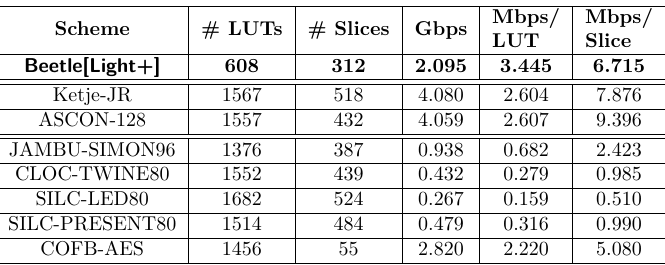
Table 6: Benchmarking Beetle[Light+] on Virtex 7.